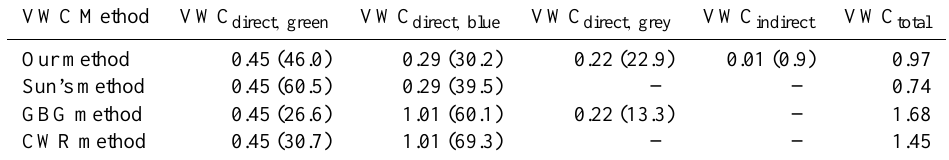
Table 2. The volume (m 3 kg − 1 ) and proportion (%) of VWC of rice in Heilongjiang Province by four different